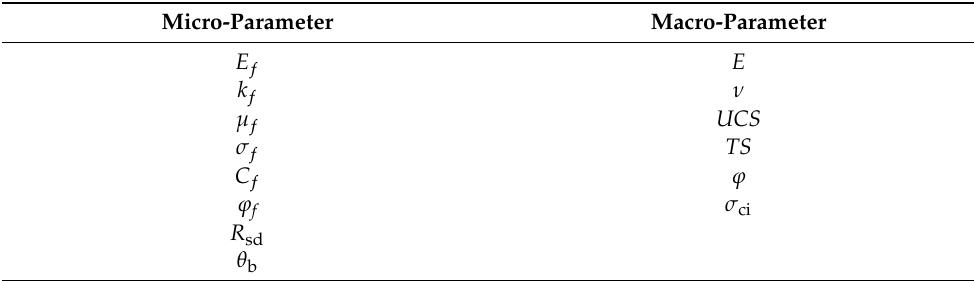
Table 1. The selected micro and macro parameters. Micro-Parameter